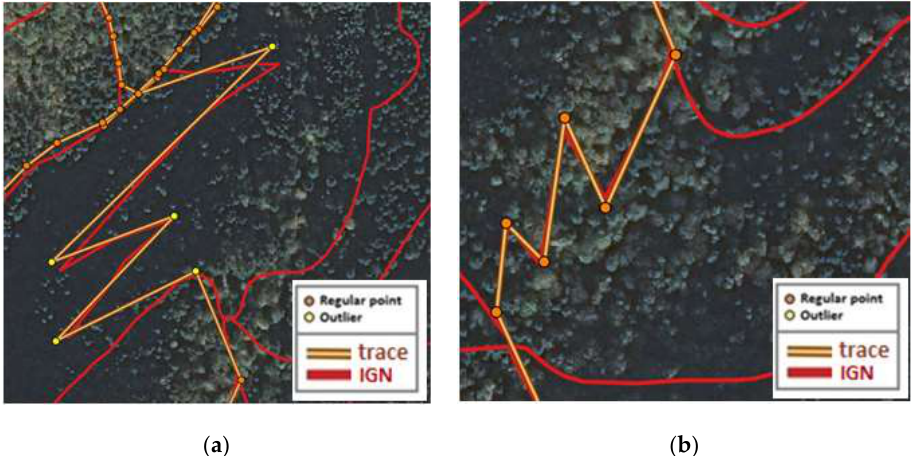
Figure 11. Outliers detection for high sinuosity paths: ( a ) False-positive outliers ( b ) and correctly detected non-outlier points.